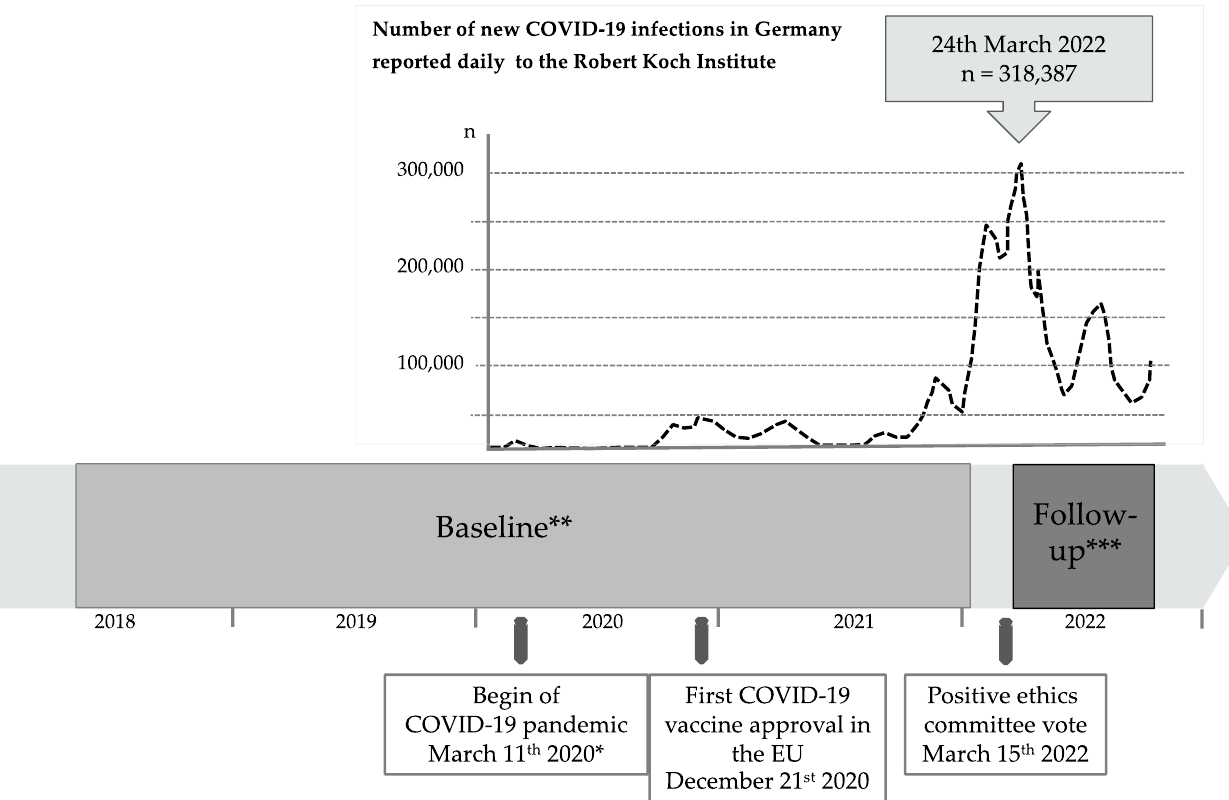
Figure 3. Timeline of blood sampling. The figure shows the number of new COVID-19 infections in Germany based on data provided by the Robert Koch Institute [31]. * The global spread of COVID-19 was declared a pandemic by the WHO on 11 March 2020. ** Baseline blood parameters were taken from each patient ’ s medical record. All blood specimens were taken before the first COVID-19 infection or COVID-19 vaccination (median: 200 days; 25 – 75% percentiles: 102.5 – 354.0; timeframe: 2 May 2018 – 6 January 2022). *** Follow-up blood parameters were taken after the last COVID-19 infection or COVID-19 vaccination at the patient ’ s visit to the outpatient clinic (median: 142 days; 25 – 75% percentiles: 88.5 – 199.0; timeframe: 17 March 2022 – 24 October 2022). Two patients were neither infected nor had they been vaccinated. In these patients, the time span between the baseline and follow-up blood parameters was 434 and 177 days, respectively.